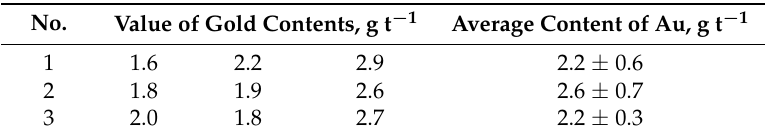
Table 4. Results of the SV determination of gold in different samples of carbonaceous shales in the